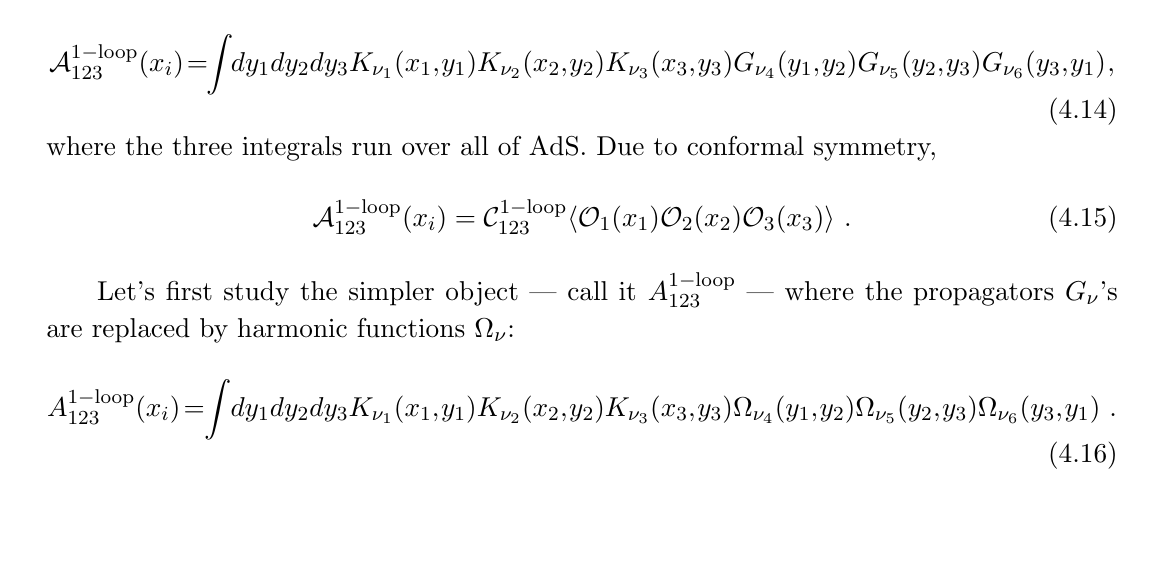
. Orange points denote AdS 123